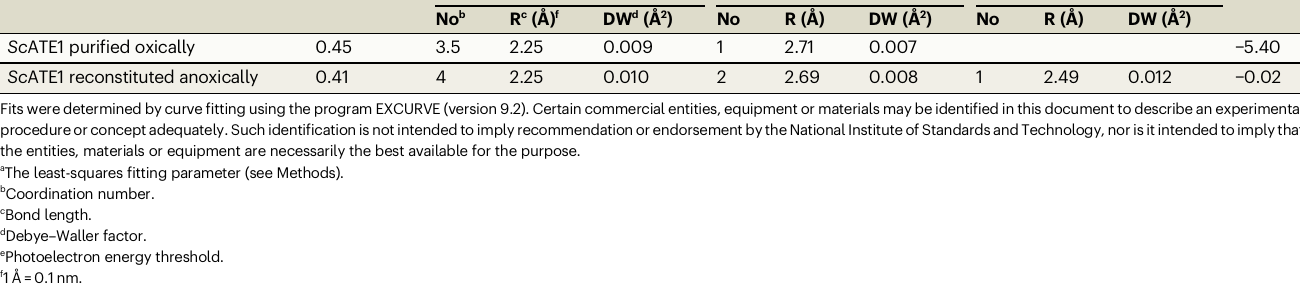
Table 1 | Fits obtained for the Fe K-EXAFS ScATE1 puri fi ed under oxic conditions and containing a [2Fe-2S] cluster, and ScATE1 reconstituted under anoxic conditions and containing a [4Fe-4S] cluster